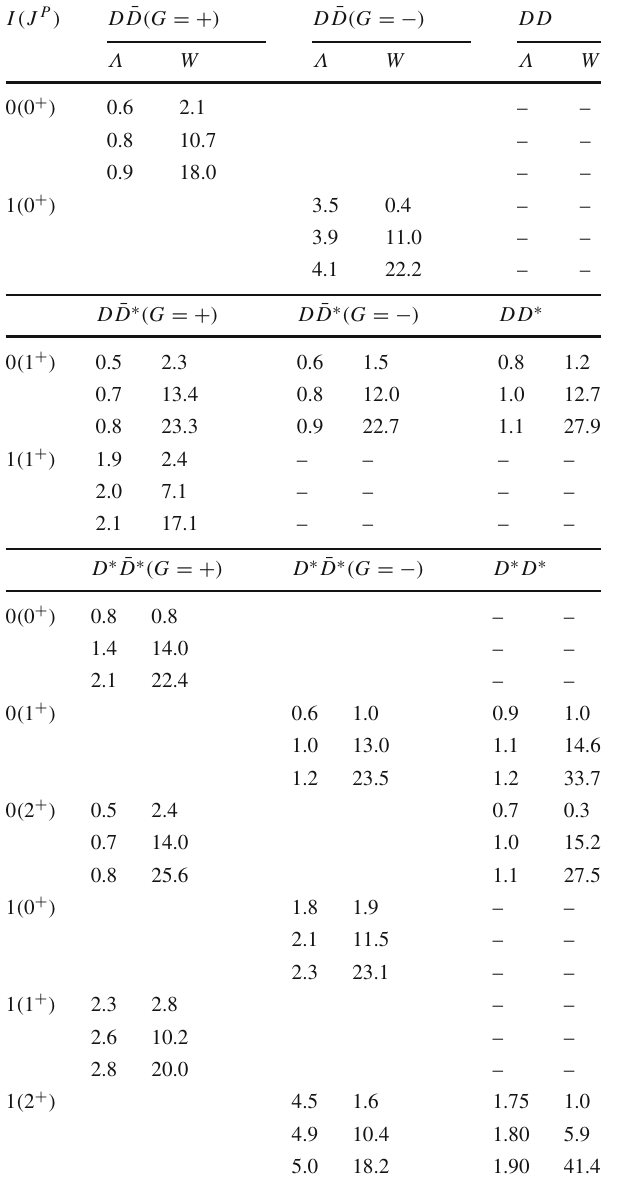
Table 2 The binding energy of the bound states from the D ( ∗ ) ¯ D ( ∗ ) and D ( ∗ ) D ( ∗ ) interactions with some selected values of cutoff Λ . The “ −− ” means that no bound state is found in the considered range of the cutoff, and blank means that the quantum number is forbidden. The Λ and W are in the units of GeV and MeV, respectively